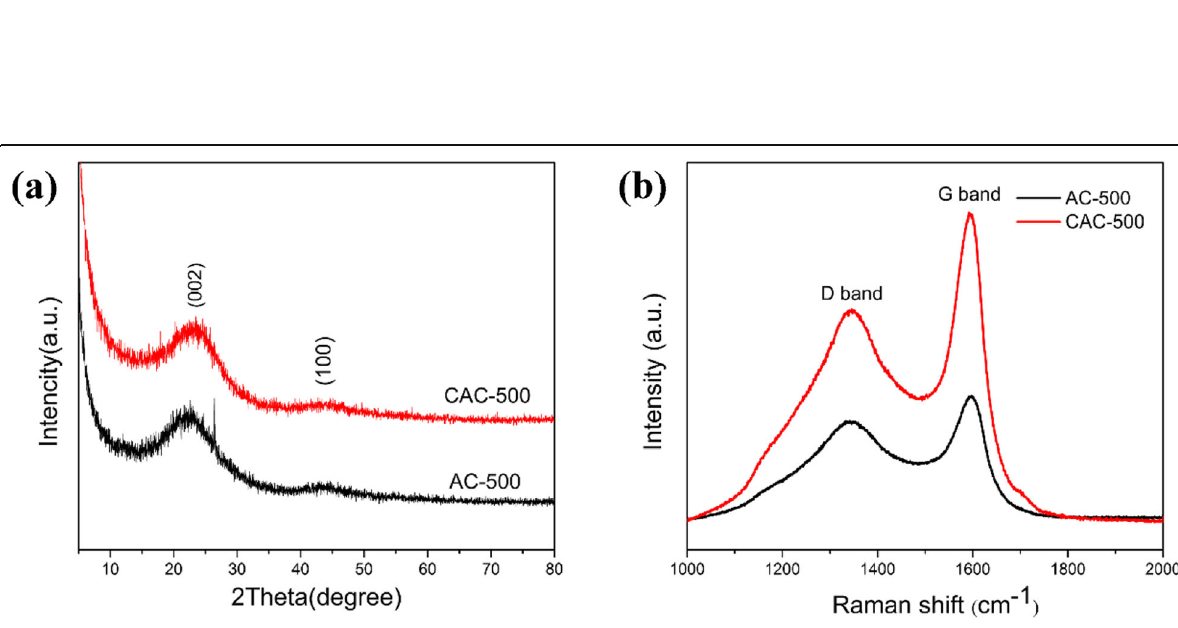
Fig. 4 a X-ray diffraction patterns. b Raman spectrums of AC-500 and CAC-500